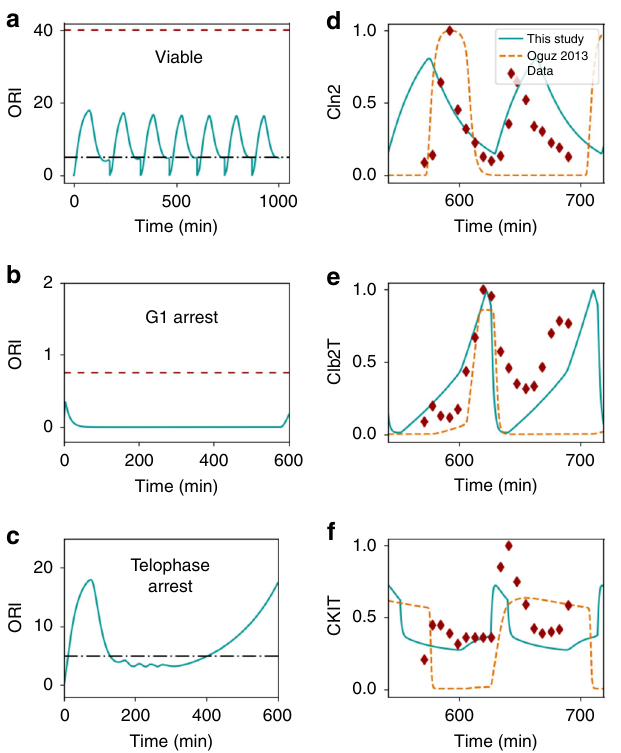
Fig. 4 The yeast cell cycle model is fi t to both qualitative and quantitative data. a – c Three different yeast strains satisfy different requirements with respect to the output variable ORI. Black dash-dot lines indicate a value that the time course must reach at some point, and red broken lines indicate a value the time course must never reach. a Wild type, viable cell. b cln 3 Δ bck 2 Δ mutant, with a G1 arrest phenotype c cdc 14- ts mutant, with a telophase arrest phenotype. d – f Fits to quantitative data (red diamonds) for three selected model output variables. Our fi ts (solid blue curves) are compared to the results from ref. 7 (orange broken curves), which were not fi t to quantitative data